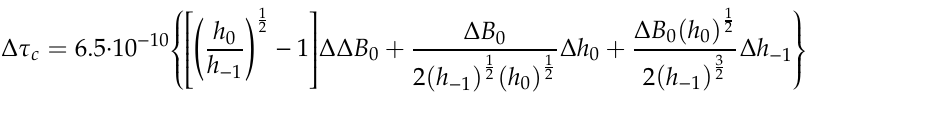
Supplementary Materials: The following are available online, Figure S1: overlay of ESR spectra; Figure S2: chemical shift perturbation values of β 2m amide signals under di ff erent conditions; Figure S3: relative intensity plots of 8 µ M + 0.8 mM Tempol under magnetization equilibrium and o ff -equilibrium conditions; Figure S4: 15 N Table S1: A N values plotted in Figure 1 and corresponding errors; Table S2: A N values plotted in Figure 2 and corresponding errors; Table S3: individual peak signal-to-noise ratios of 15 N- 1 H HSQC